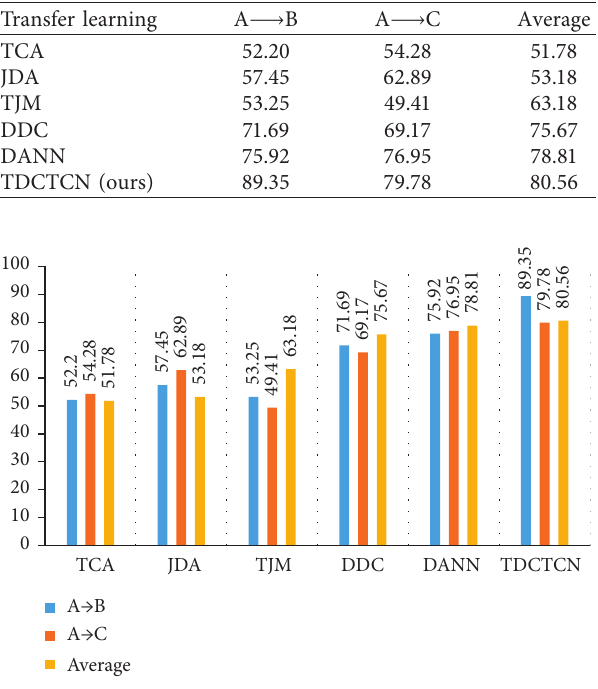
Figure 12: Transfer accuracy for transfer tasks